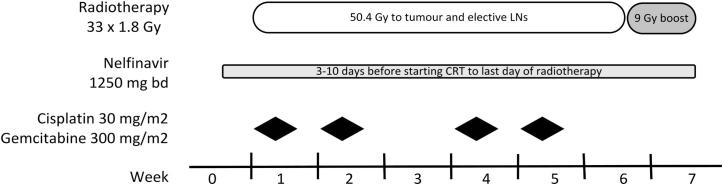
ARC-II trial design.